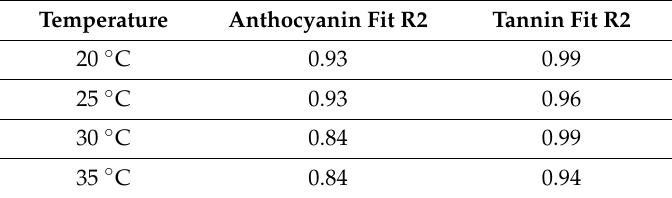
Figure 4. Phenolic Extraction Model Fits. The temperature extremes of 20 ◦ C ( A ) and 35 ◦ C ( B ) are shown to indicate the range of fits. Blue dots: anthocyanin data. Blue curve: model anthocyanin fit. Orange dots: tannin data. Orange curve: tannin fits. Table 3. R 2 (Goodness of Fit) for Extraction Model Fits at each temperature.